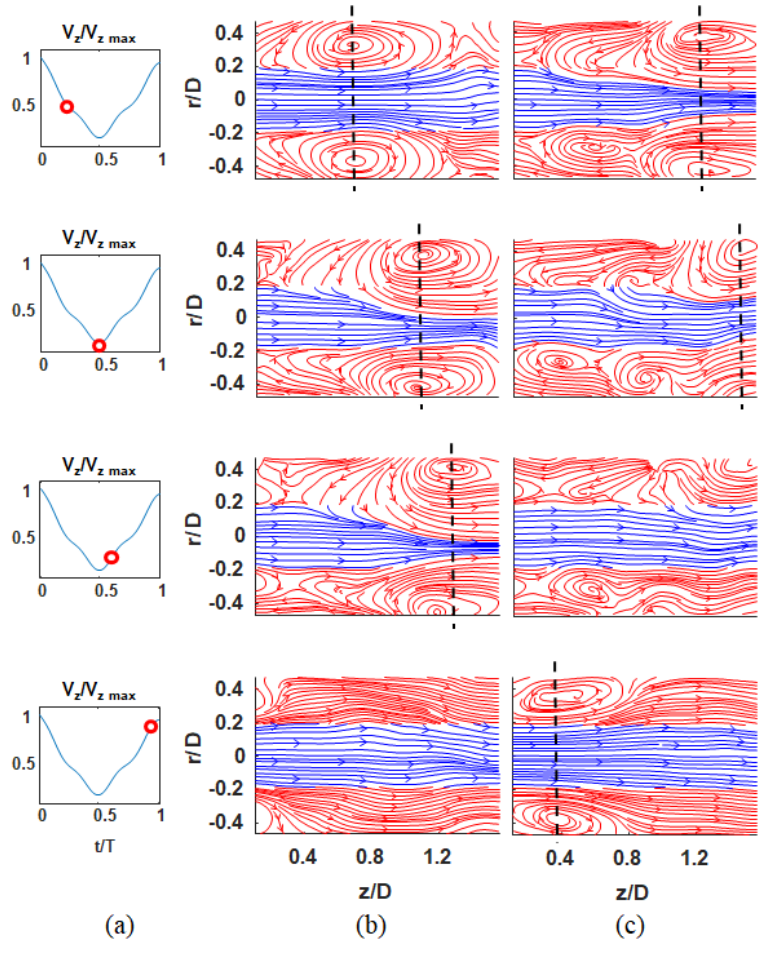
Figure 8: (a) Axial velocity profile at z = 0 and r = 0 and time at which the velocity field was obtained (red circles); (b) streamlines derived from experimental data for ¯ Re = 1002, with d 0 = 1.0 cm; (c) streamlines derived from experimental data for ¯ Re = 1767, with d 0 = 1.0 cm. In both cases, red streamlines represent the recirculation zone and blue streamlines the central jet (colours available online